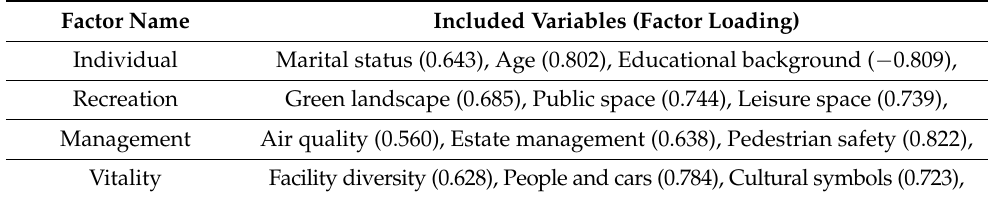
Table 6. Exploratory factor analysis of